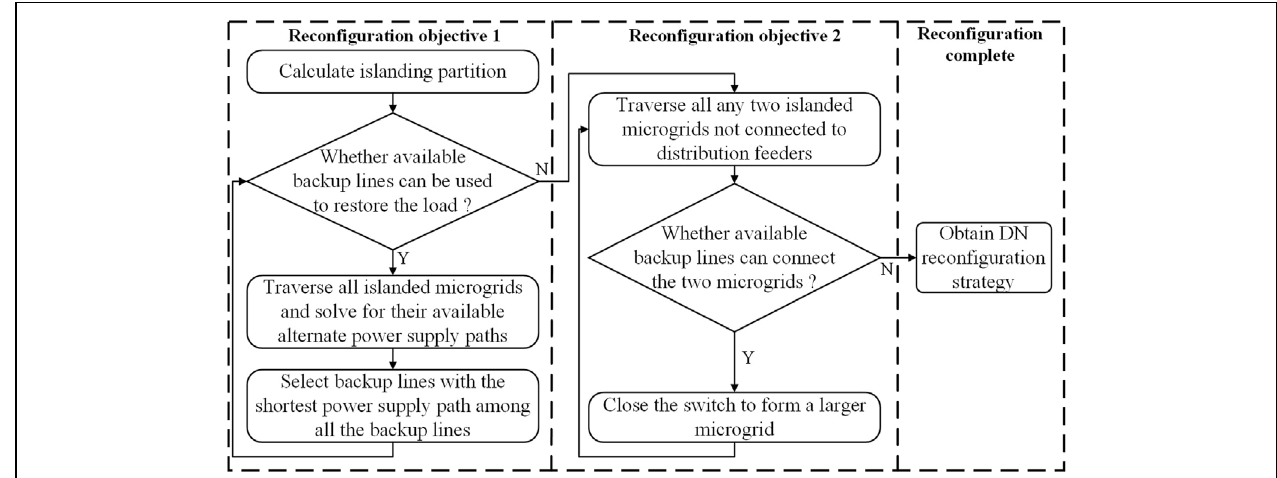
FIGURE 5 | DN reconfiguration